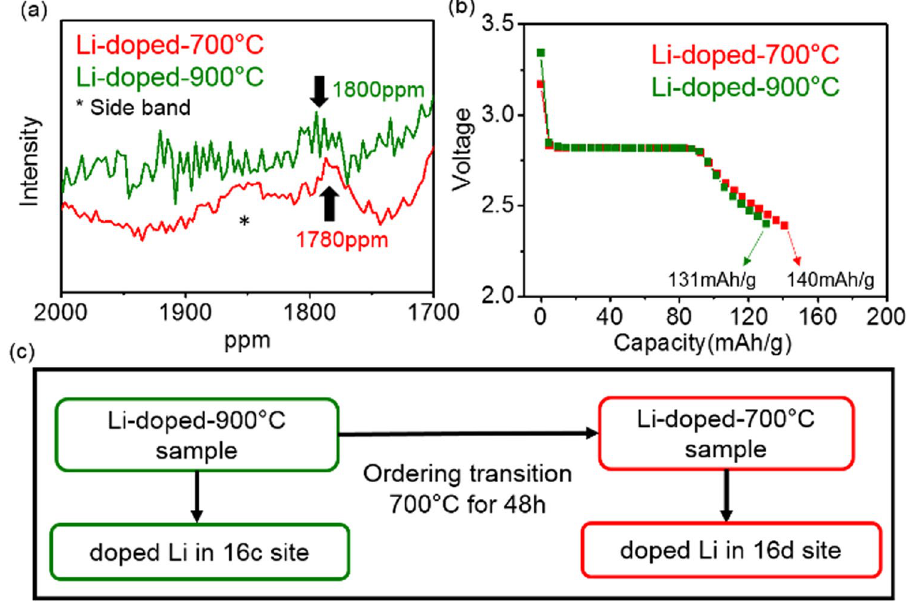
Figure 6. Comparison ( a ) 7 Li MAS NMR spectra around 1800 ppm for the Li-doped-900 °C and Li-doped − 700 °C sample (asterisk * : sideband) ( b ) Open circuit voltage (OCV) profiles below 3 V with discharging first of the two Li-doped samples ( c ) Schematic diagram of the occupation of the doped Li in the Li-doped samples during 2 nd annealing process at 700